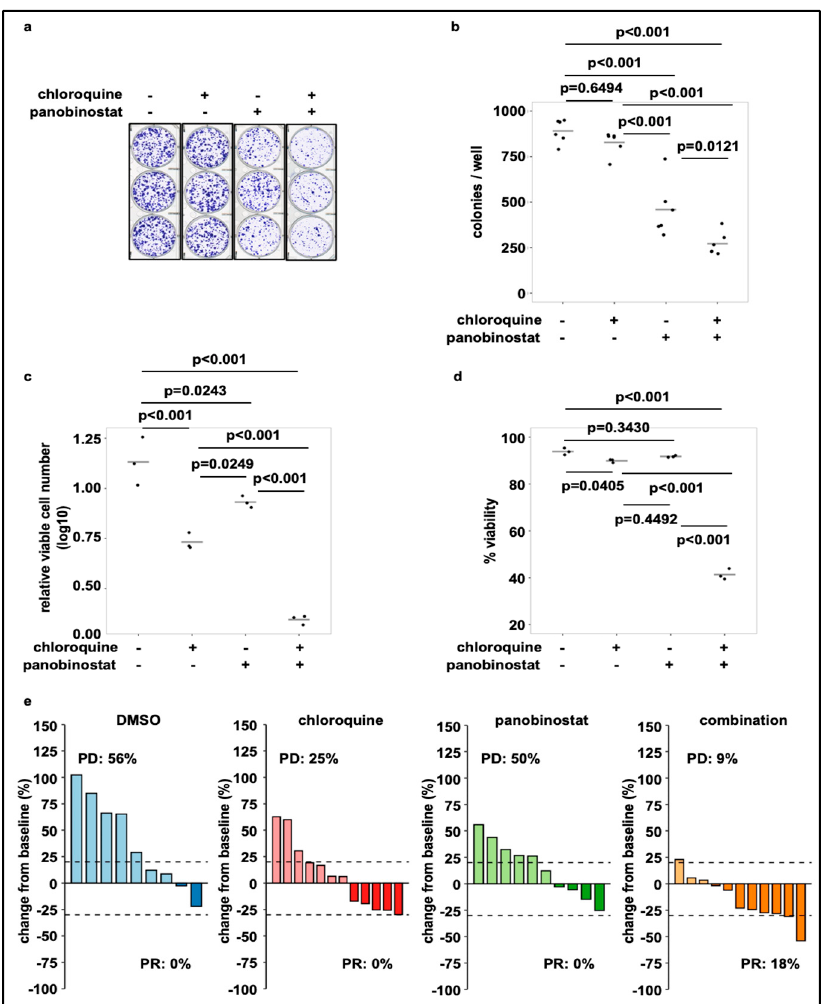
Figure 5. Treatment with panobinostat in combination with chloroquine reduces cell viability and colony growth. ( a ) Colony formation assay of SK-N-BE(2)-C neuroblastoma cells treated for 24 h with chloroquine (20 µ M) or panobinostat (10 nM) alone or in combination. Shown are 6 technical replicates from two independent experiments. ( b ) Quantification of grown colonies after treatment of SK-N-BE(2)-C cells for 24 h with chloroquine (20 µ M) or panobinostat (10 nM) alone or in combination. ( c ) Viable cell number (normalized to DMSO) of SK-N-BE(2)-C cells after 72 h treatment with chloroquine (20 µ M) or panobinostat (10 nM) alone and in combination. ( d ) Viability of SK-N-BE(2)-C cells after 72 h treatment with chloroquine (20 µ M) or panobinostat (10 nM) alone and in combination. ( b – d ) Statistical analyses: ANOVA with Tukey’s multiple comparison test. ( e ) Waterfall plots demonstrating change in tumor volume (%) for each individual xenograft, from baseline (day 1 = start of the treatment) to day 3 after yolk sac-implantation of SK-N-BE(2)-C cells. Dotted lines are drawn according to Response Evaluation Criteria in Solid Tumors (RECIST) 1.1 adopted for zebrafish tumors, to visualize best response: progressive disease (PD), at least a 20% increase in tumor volume; partial response (PR), at least a 30% decrease in tumor volume; each bar reflects one individual xenograft. The following concentrations were applied: chloroquine: 100 µ M; panobinostat: 200